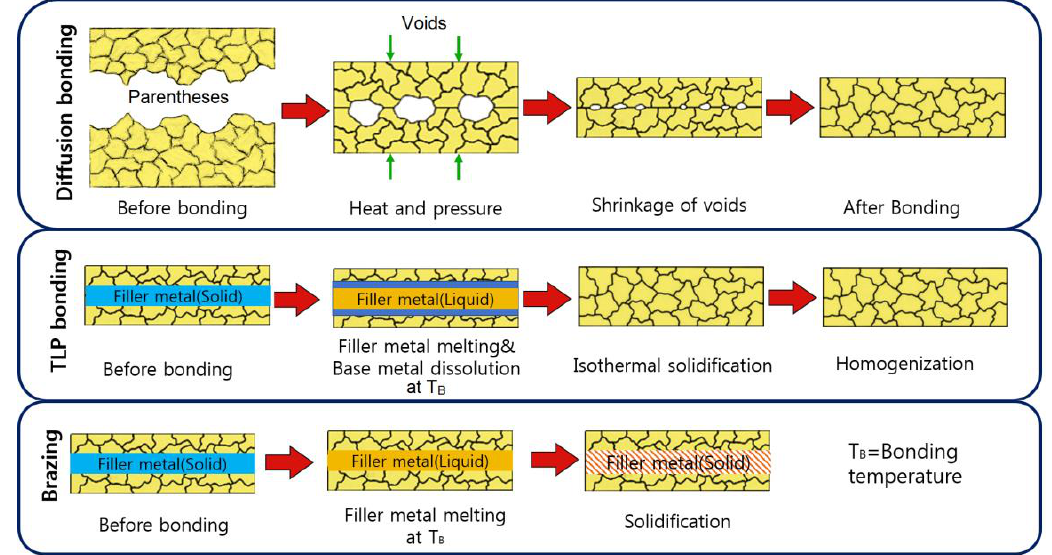
Figure 3. Schematics of diffusion bonding, TLP, and brazing processes.